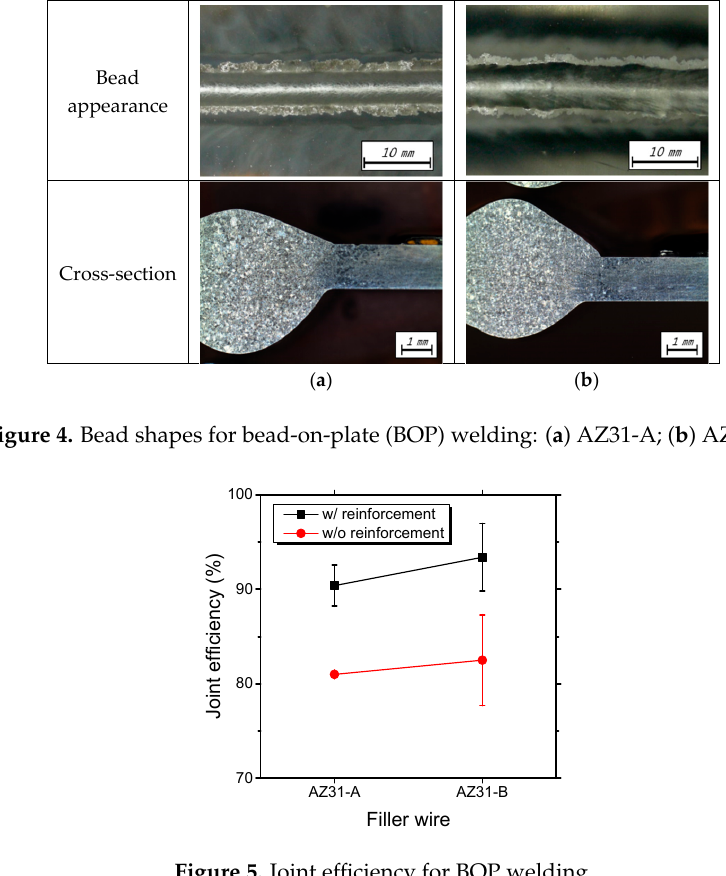
Figure 6. Fractured specimen with and without reinforcement by tensile test.